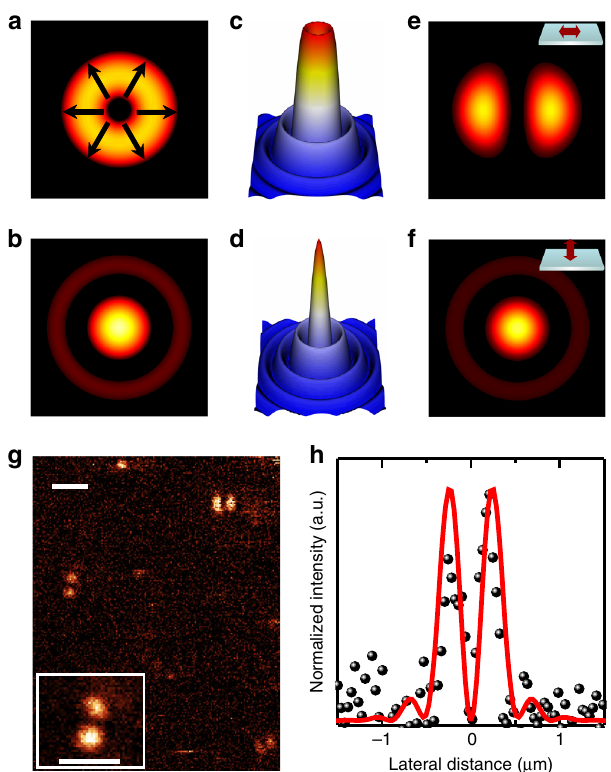
Fig. 3 Higher-order laser mode scanning microscopy of single CdSe quantum rings. a , b Numerically simulated transverse and longitudinal components of a radially polarized Bessel-Gauss laser beam. c, d The corresponding intensity pro fi les of the transverse c and longitudinal d electromagnetic components. e, f Calculated excitation patterns of a uniaxial TDM lying horizontally e or vertically f on the sample plane. g Experimentally measured excitation patterns of individual CdSe QRs. h Calculated intensity pro fi les of a horizontally lying uniaxial TDM (curve) and measured intensity pro fi les from the excitation patterns of a single CdSe QR (dot). The dimensions of a , b , e , f are 1.27 × 1.27 µ m 2 . The dimensions of c , d are 2.53 × 2.53 µ m 2 . The scale bars in g are 1 µ